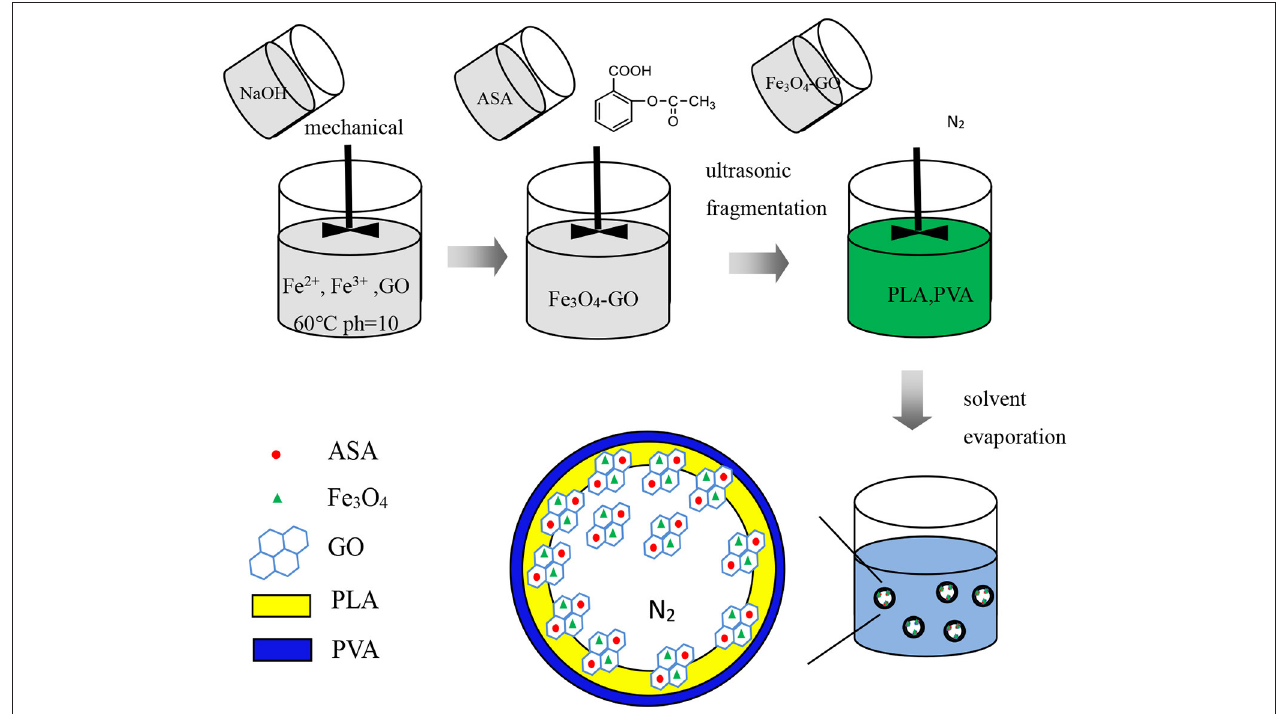
FIGURE 6 | Preparation process of PLA combined Fe 3 O 4 -GO-ASA nanobubbles.